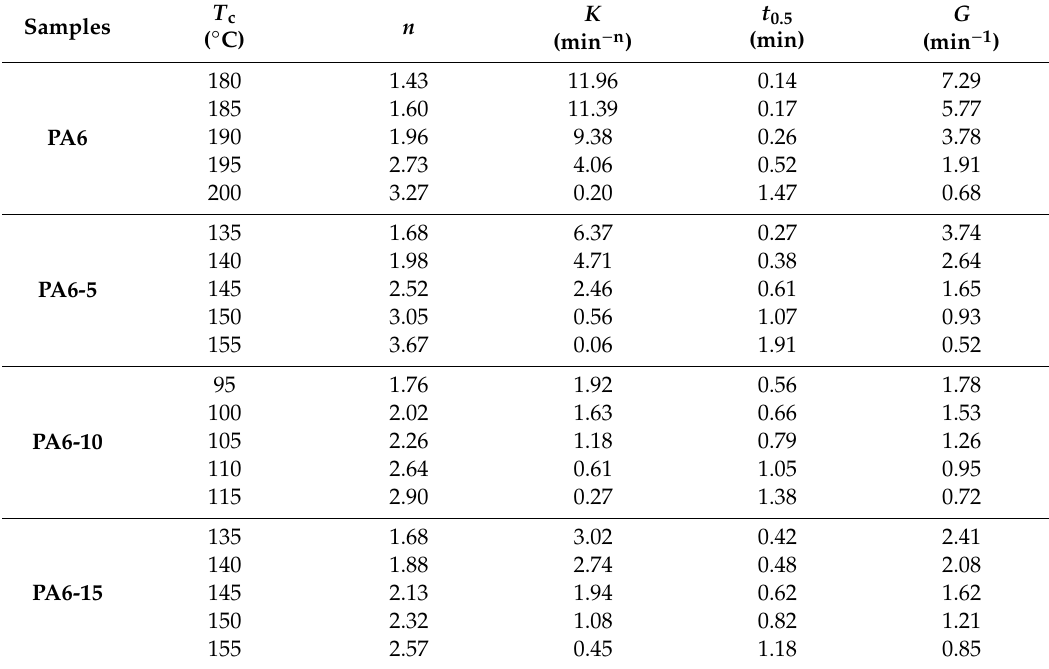
Table 2. The parameters of the isothermal crystallization kinetics of the pure PA6 and its copolyamides.